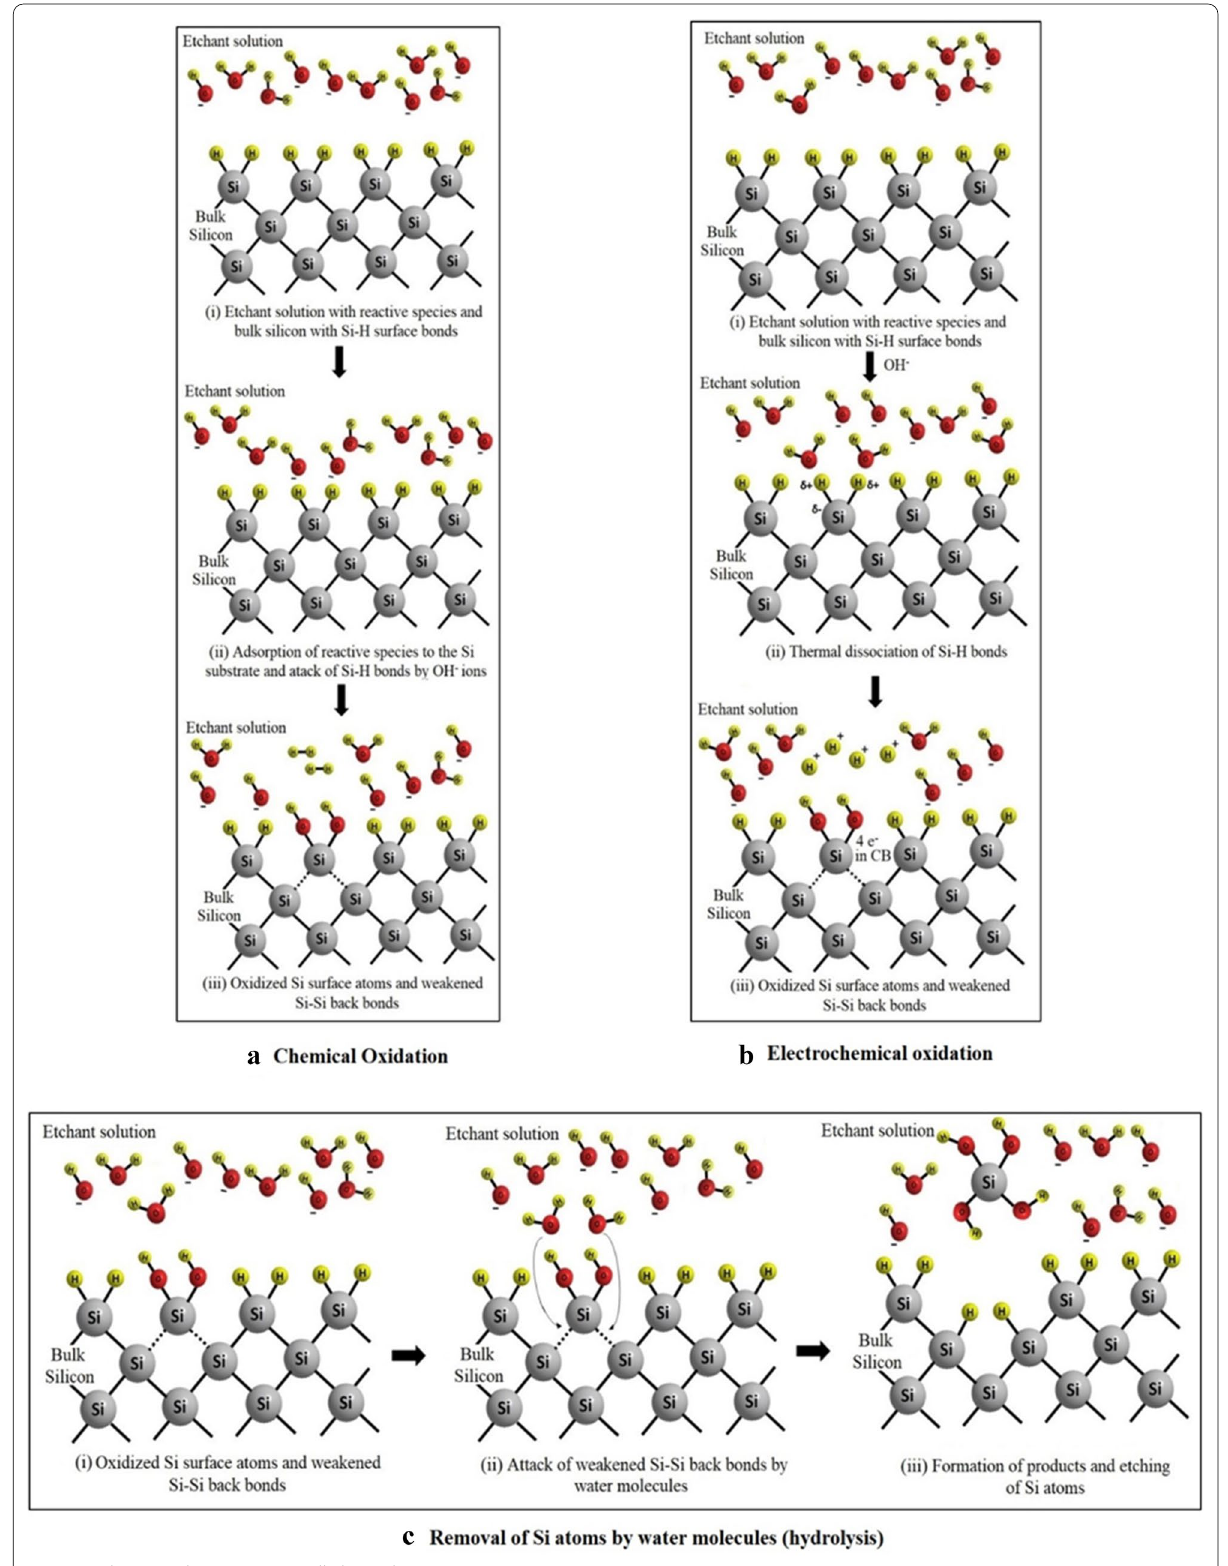
Fig. 5 Etching mechanism in pure alkaline